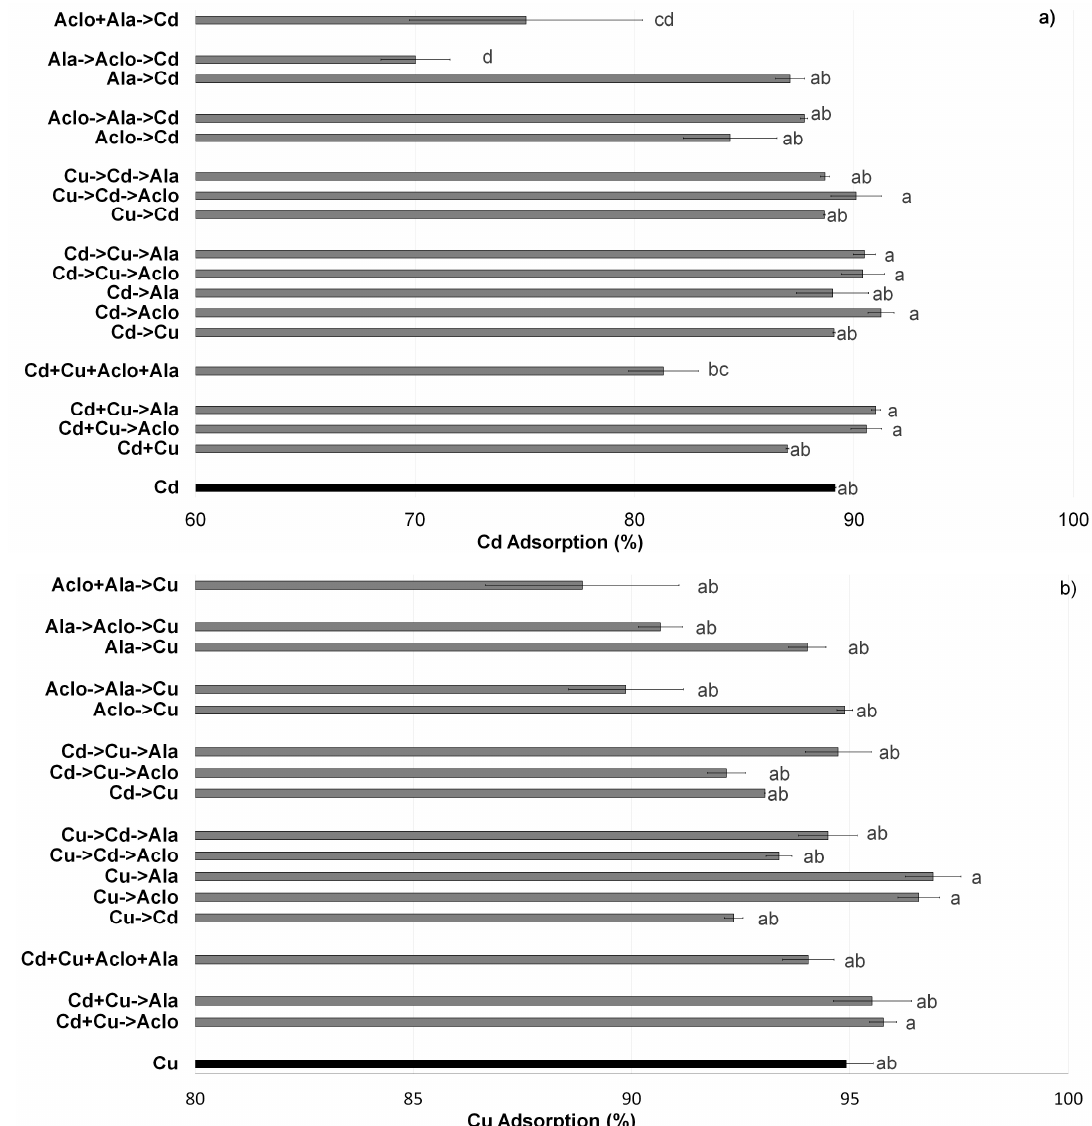
Figure 7. Average percentage of Cd ( a ) and Cu ( b ) adsorbed on Suspended Matter in different multipollution scenarios. Means with the same letter (a, b, c, d) are not significantly different (ANOVA, p < 0.05). In the lower graph, all means are not significantly different.